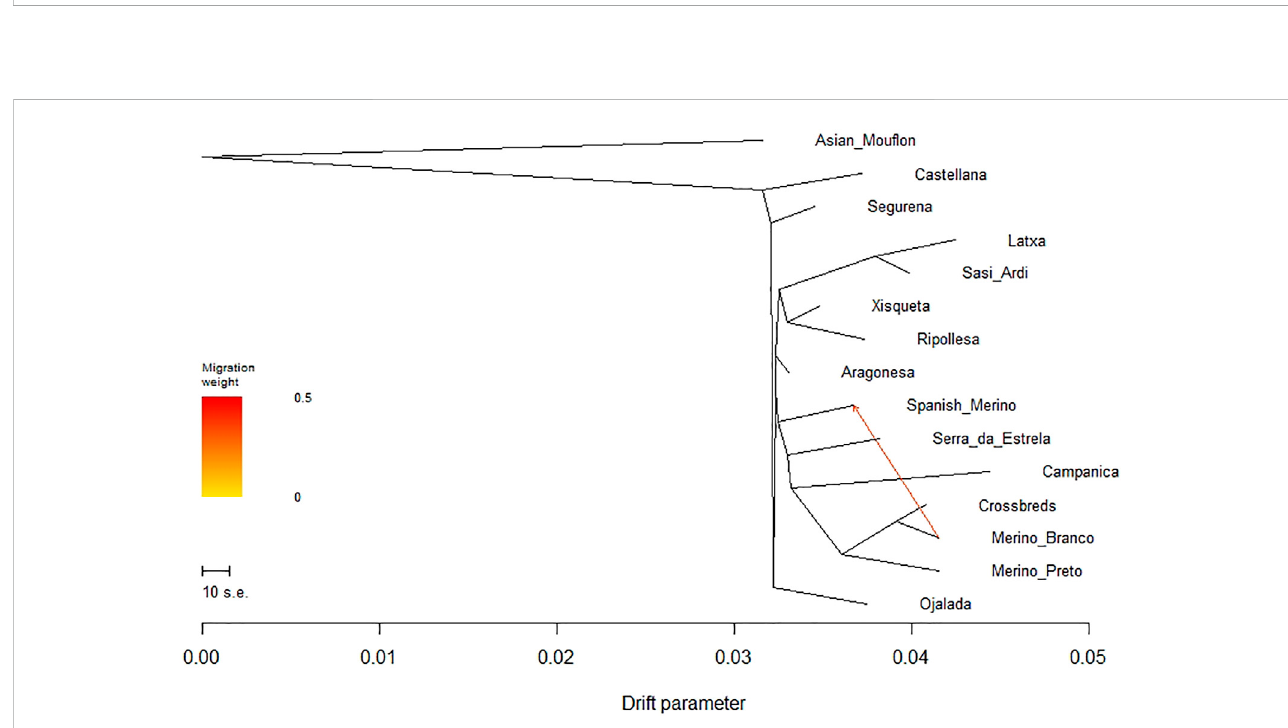
FIGURE 9 PhylogeneticnetworkinferredbyTreemixforIberiansheep.Onemigrationevent(m=1)amongpopulationswasallowedandisrepresentedbyanarrow indicating gene fl ow between Merino Branco and Spanish